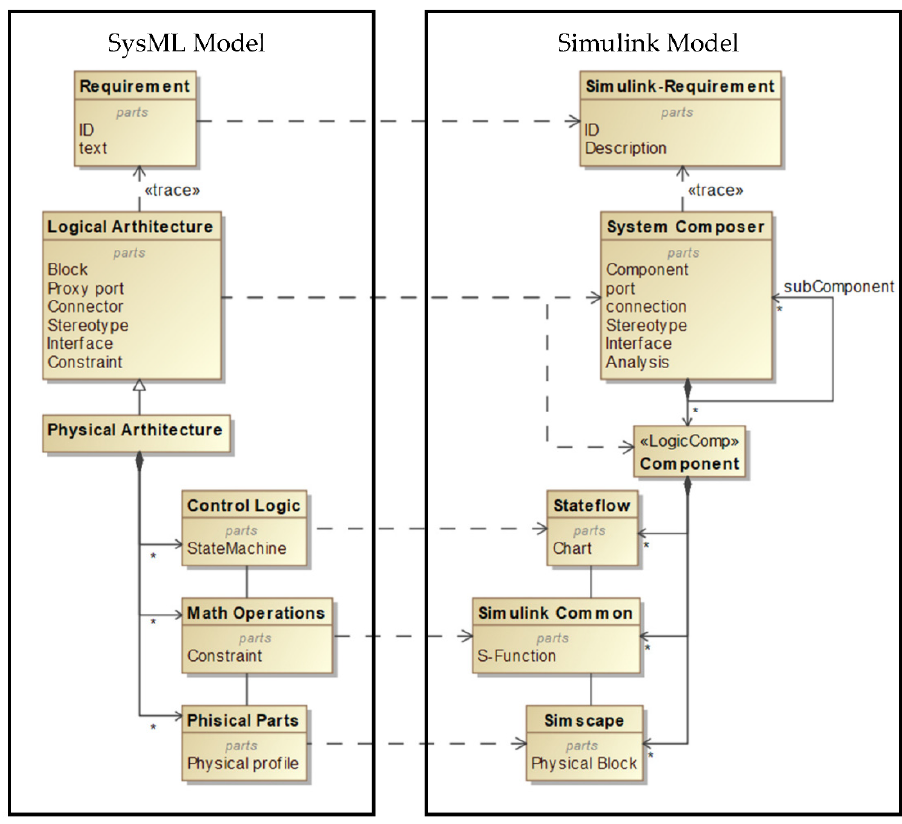
Figure 6. Mapping relationship of architecture between SysML Simulink.